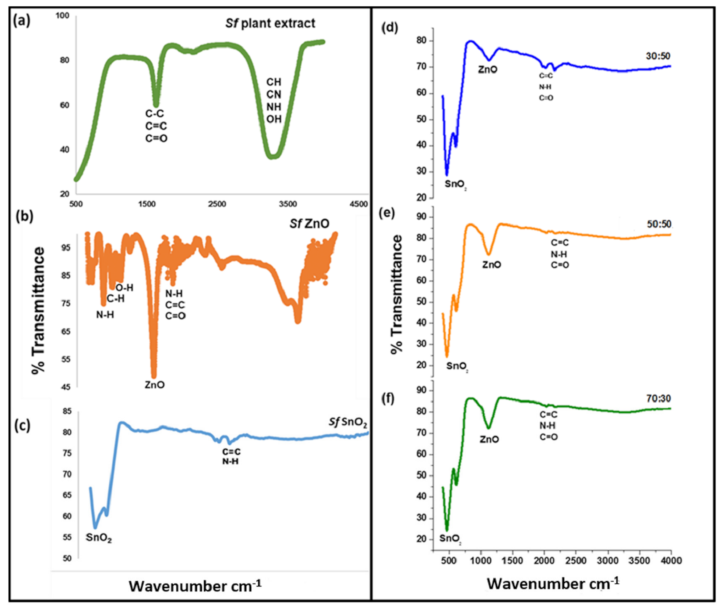
Figure 2. FTIR analysis of ( a ) Sf plant extract, ( b ) Sf ZnO, ( c ) Sf SnO 2 , bimetallic nanoparticles at different loadings of ( d ) 30:70, ( e ) 50:50 and ( f )